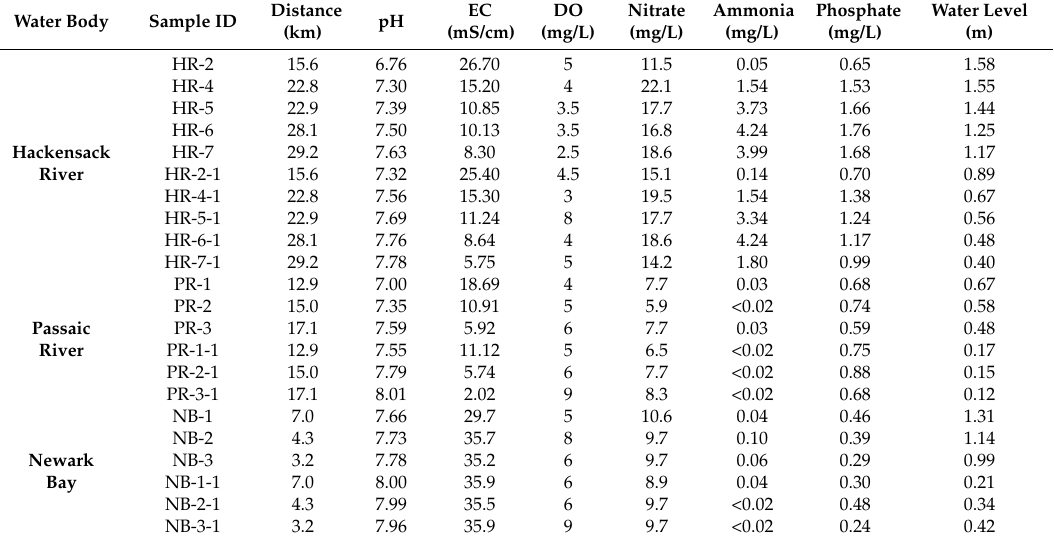
Table 3. Water quality data for the Hackensack River, the Passaic River, and the Newark Bay collected during a tidal cycle (no shade: high water level, gray shade: low water level) in summer 2016. Distance (km) indicates the distance from NB-6 located near the mouth of the Newark Bay. Water level data (tidal datum: mean lower low water) at Bergen Point West Reach, NY, are from National Oceanic and Atmospheric Administration